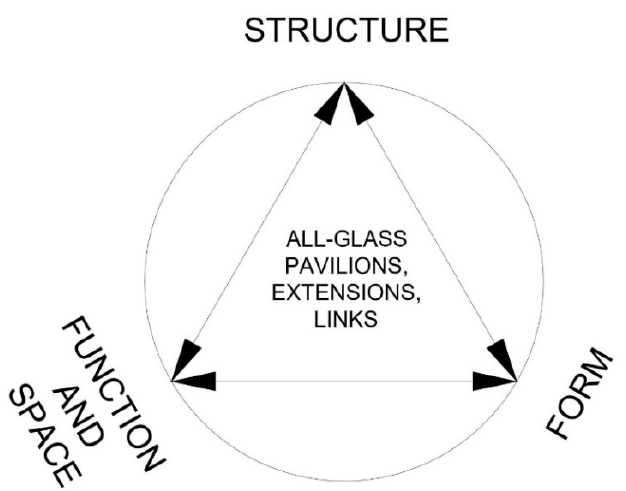
Figure 28. A diagram of the relationship between function and space, form, and structure (figure by the author).